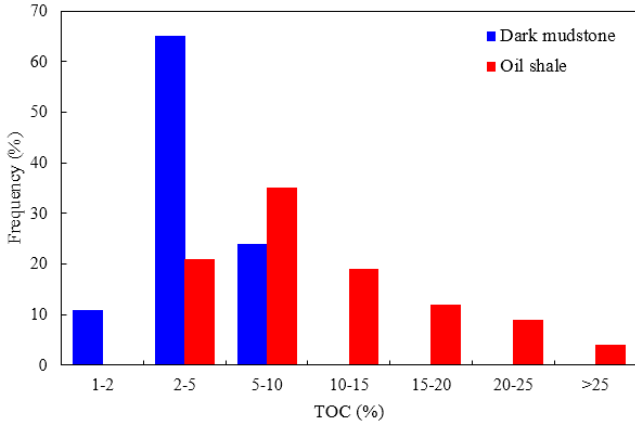
Figure 4. TOC distribution for source rocks in Chang 7 in the Ordos Basin.